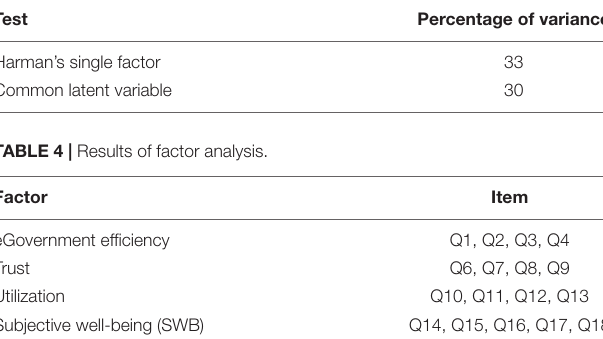
TABLE 3 | Results of common method variance test.